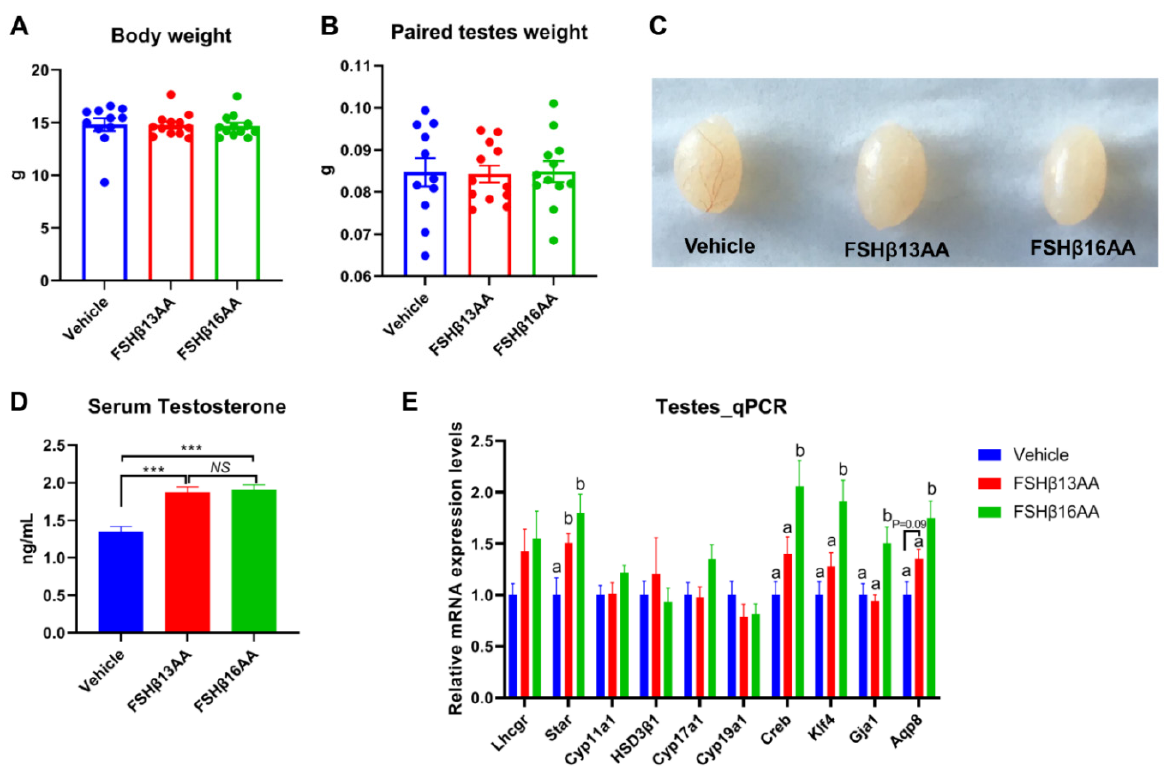
Figure 2. Repeated FSH β 13AA/FSH β 16AA treatments promote testicular steroidogenesis in prepu ‐ bertal male mice. Giving 200 μ g/g BW of either FSH β 13AA or FSH β 16AA (Figure 1A) once daily on days 25 to 28 had no significant effects on the body ( A ) or the paired testes weights ( B ) of the pre ‐ pubertal male mice on day 29. ( C ) Representative testes in all of the treatment groups. ( D ) Serum